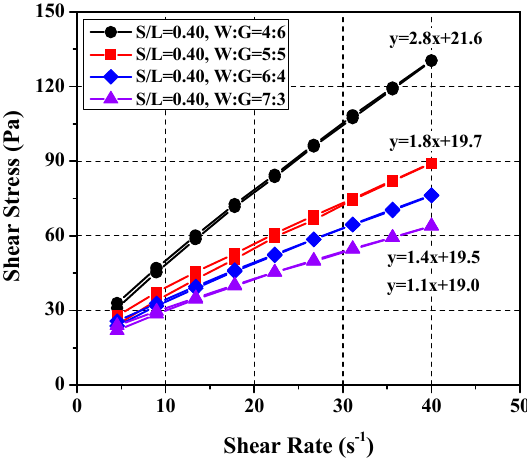
Figure 8. Variation of rheology depending on water and glycerol ratios.